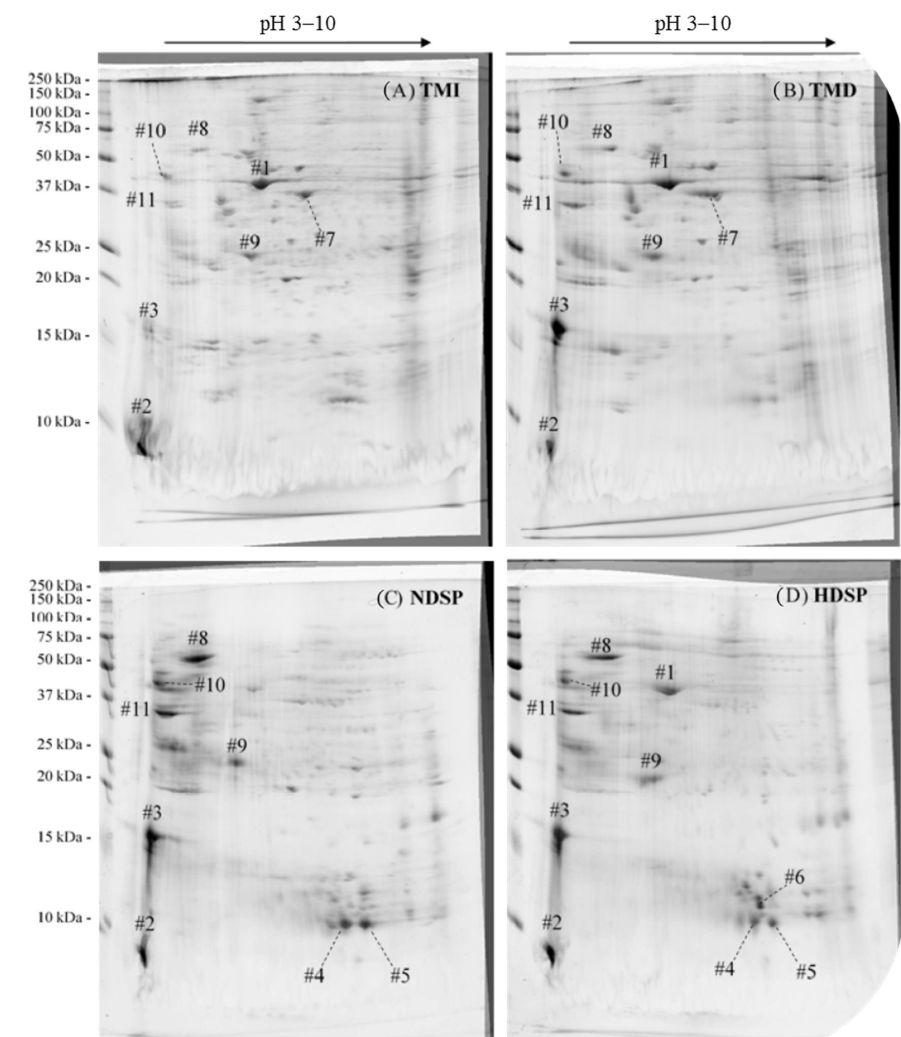
Figure 2. Two-dimensional electrophoresis of T. molitor proteins for ( A ) TMI, ( B ) TMD, ( C ) NDSP, and ( D ) HDSP. Proteins composing each numbered spot were characterized by proteomics (Table 2).